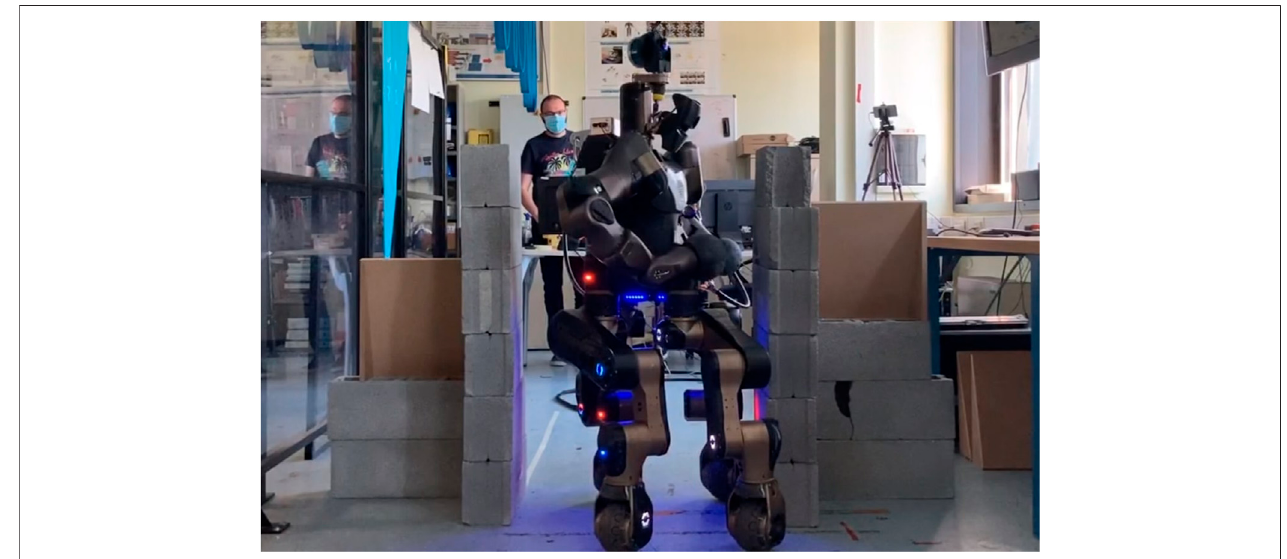
FIGURE 1 | CENTAURO passes through a corridor while the null-space posture generator (NSPG) acts by reshaping its whole-body pose.